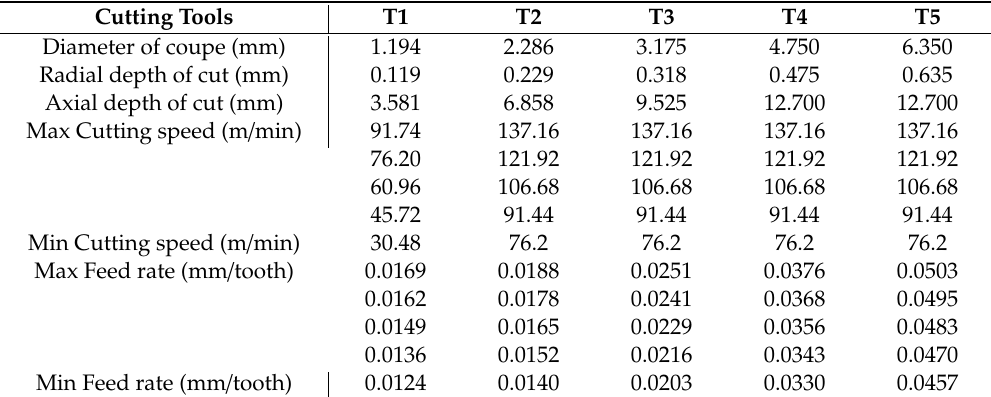
Table 3. Experimental plan for five different tool diameters.